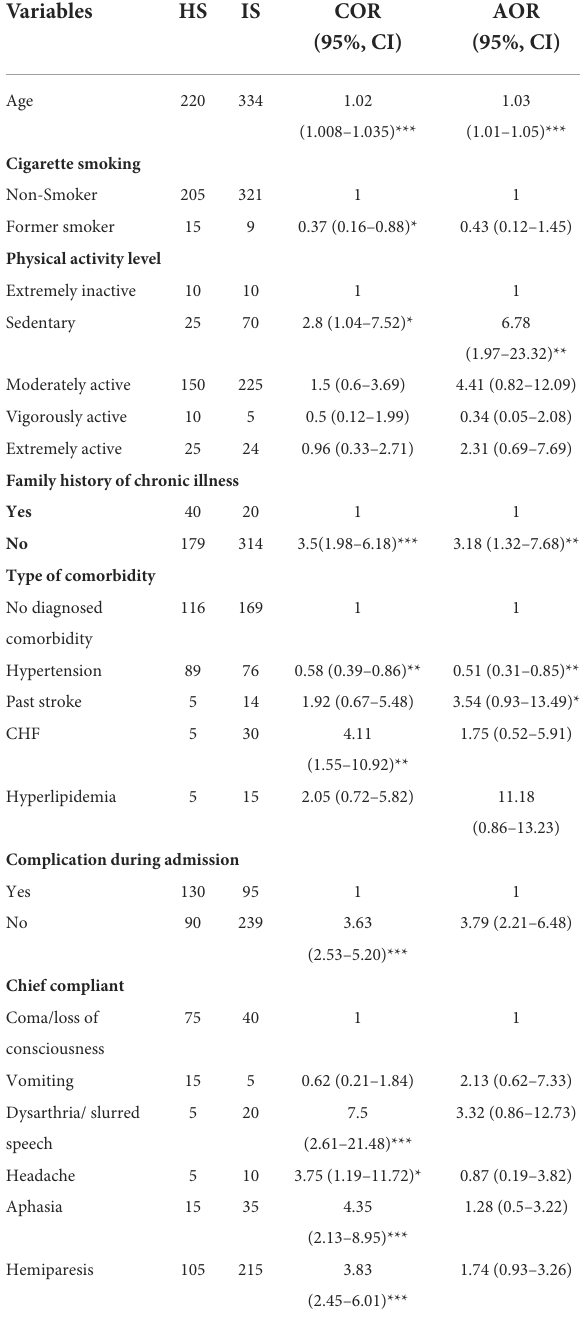
TABLE 3 Determinants of stroke subtypes among patients with stroke admitted to public referral hospitals, Northwest Ethiopia,